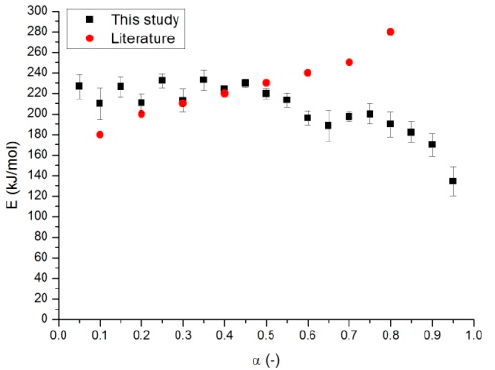
Figure 3. Activation energy distribution (with standard deviations) for solid digestate